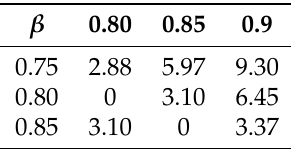
Table 6. Percentage of pixels that are classified differently when different values of β are used. The pixels that belong to land, cloud, or glint are